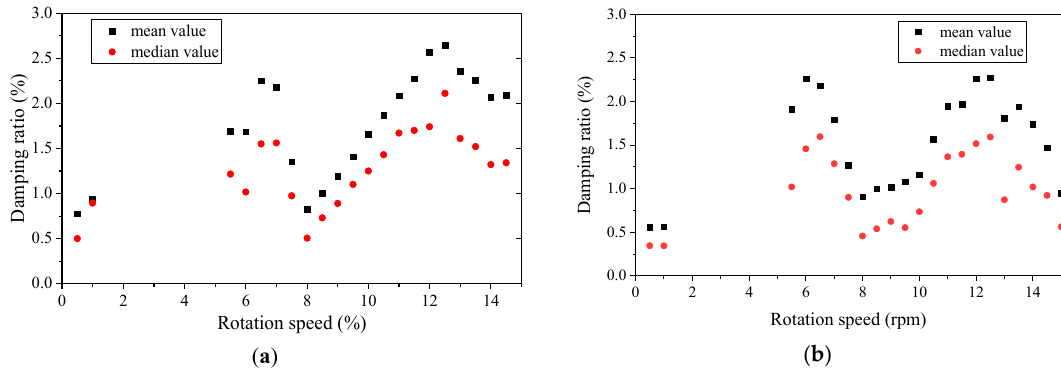
Figure 13. Campbell diagram for the damping ratio. ( a ) Averaged damping ratios identified from the strain measurements within an interval of 0.5 rpm; ( b ) averaged damping ratios identified from the acceleration measurements within an interval of 0.5 rpm.